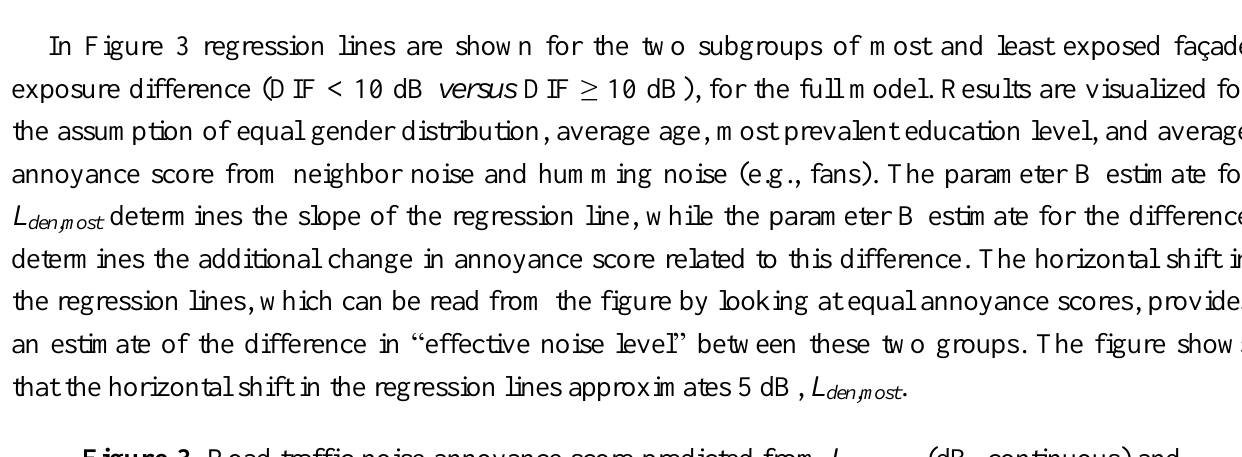
(dB, continuous) and den,most